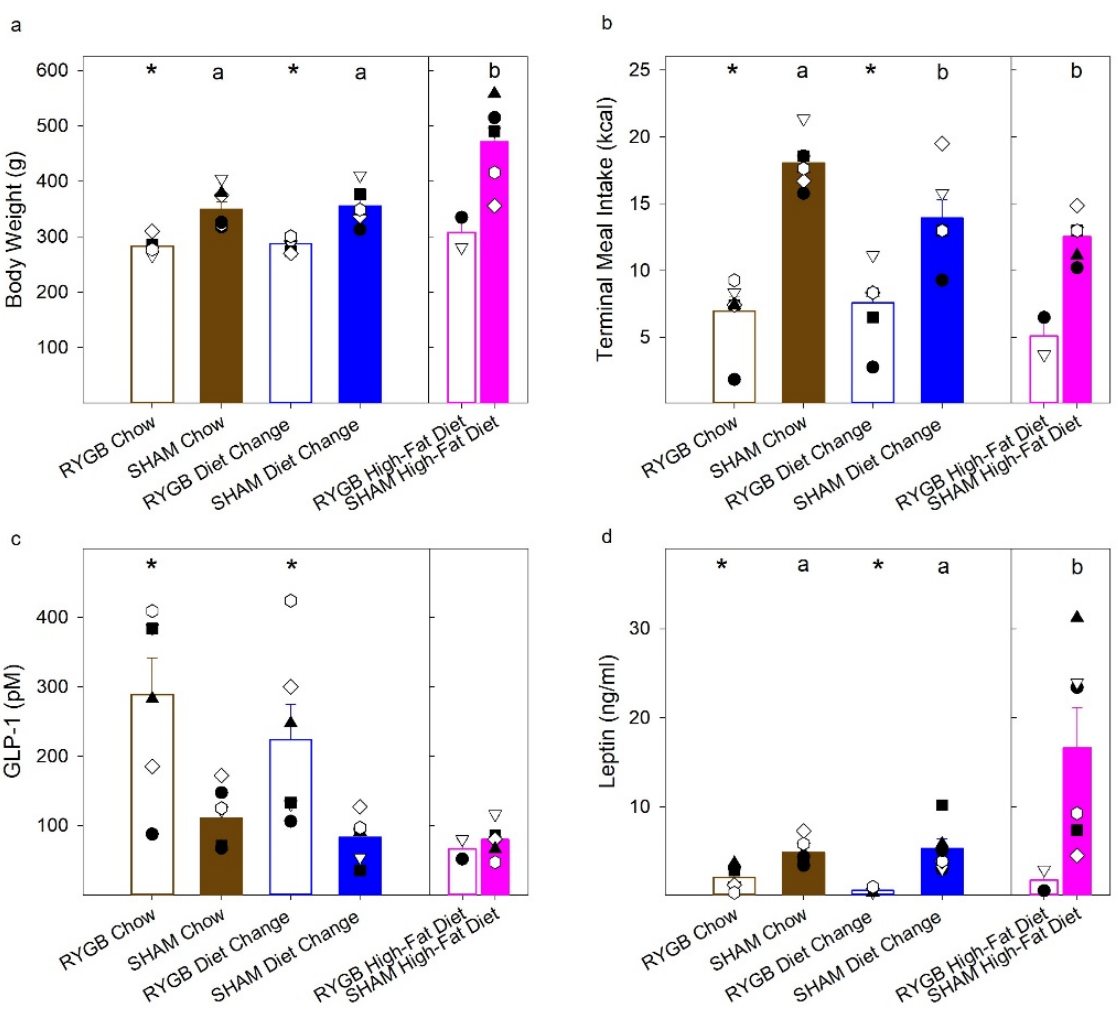
Figure 9. Terminal meal and hormone analyses. Mean ( ± SE, standard error) of the body weight on test day ( a ), total caloric intake ( b ), postprandial GLP-1 response ( c ), and plasma leptin levels ( d ). Significant differences between SHAM groups found from uncorrected paired comparisons are reflected by different black letters above the bars; “*” represents differences between surgical groups in a given diet condition. There were no differences among the SHAM diet conditions for GLP-1 ( c ); differences between total meal intake ( b ) in the Chow and DC SHAM groups did not survive Bonferroni corrections; surgical differences between the DC group for GLP-1 ( c ) and leptin ( d ) levels did not survive corrections. RYGB groups are in open bars, SHAMS in filled. Diet groups are represented as brown for the Chow group; blue, the diet change; pink, the high-fat diet.